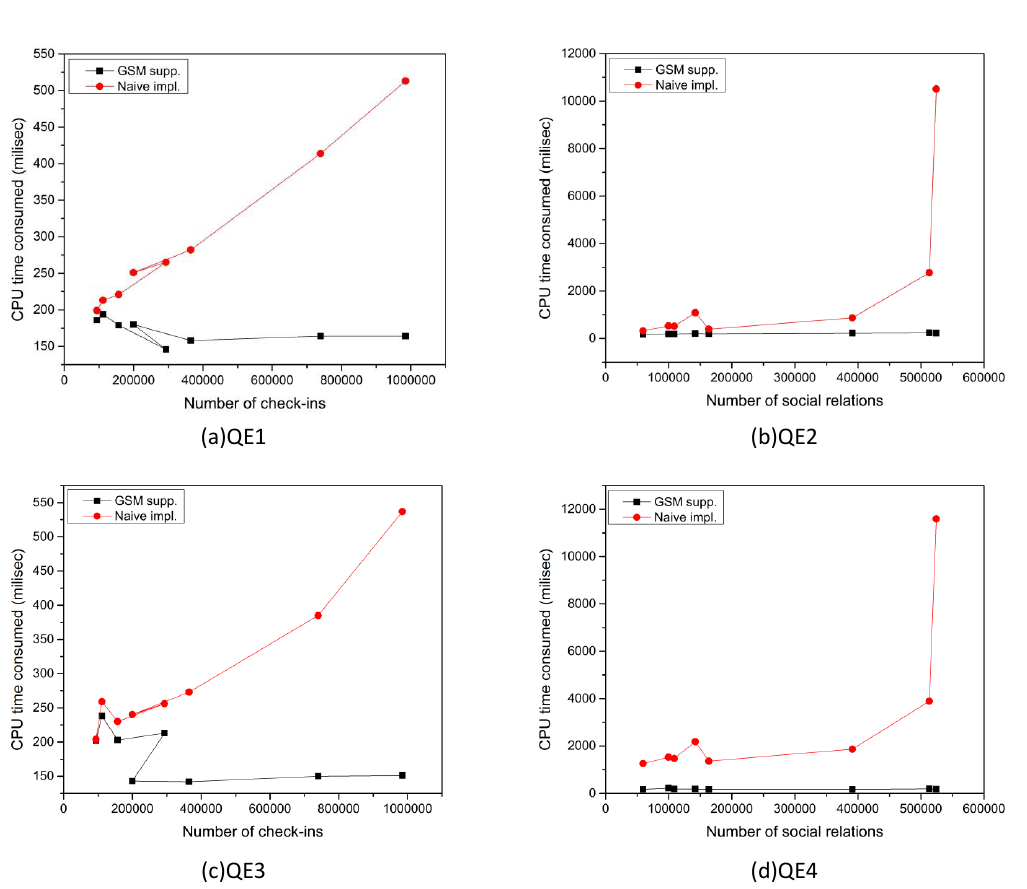
Figure 8. Relationships between performance and data volume in